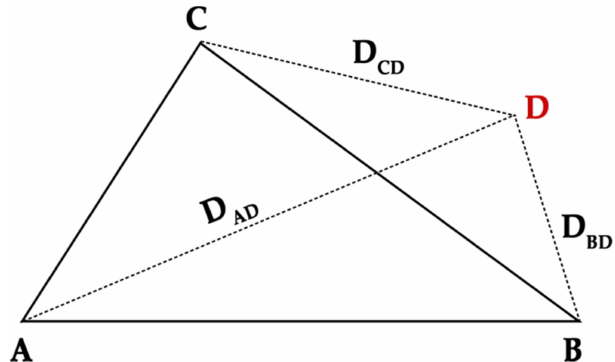
Figure 5. Calculation of the position of one point from the other three and the distance to each